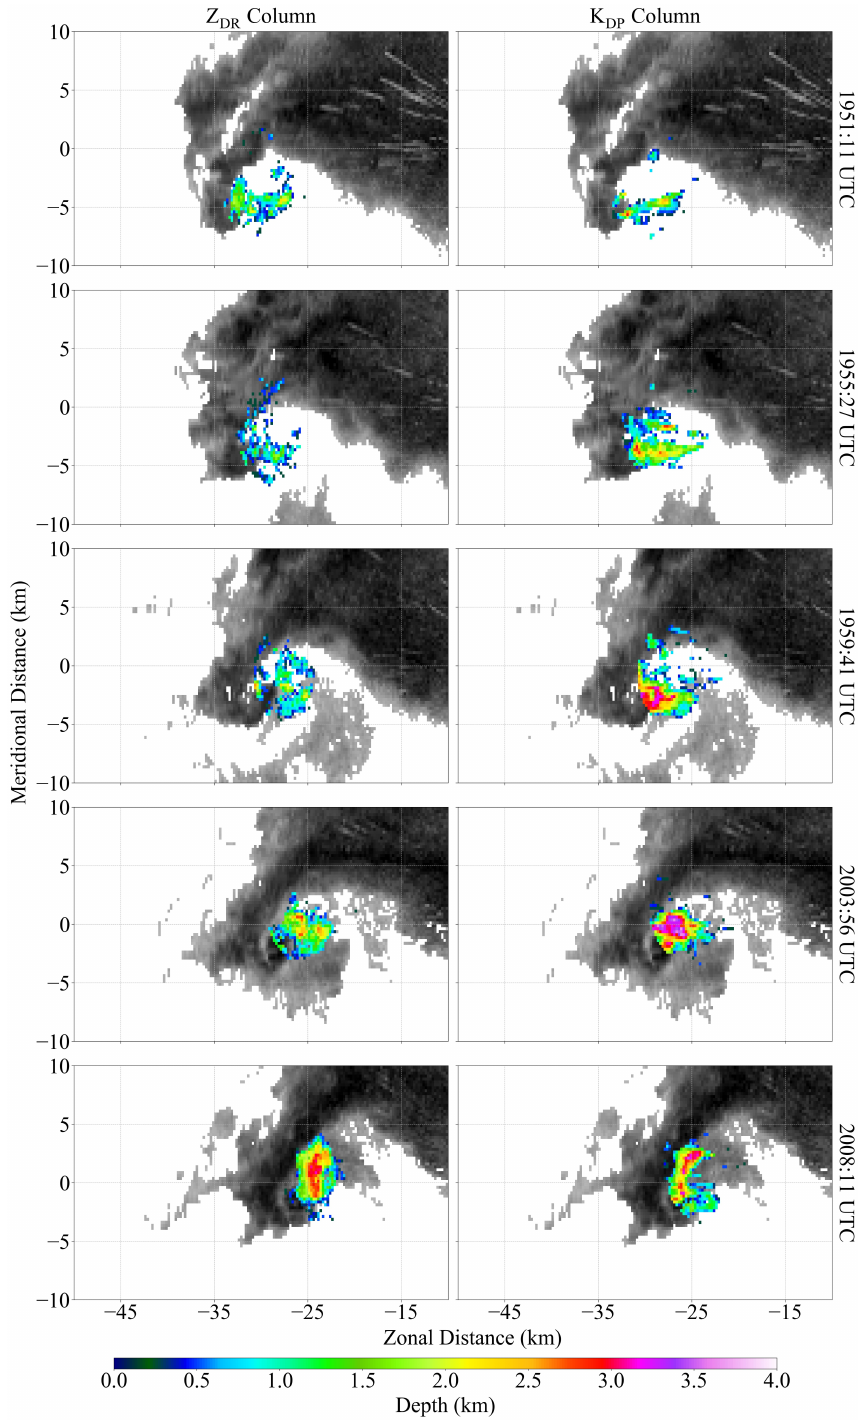
Figure 17. As in Figure 16, except from 1951:11 UTC to 2008:11 UTC (second